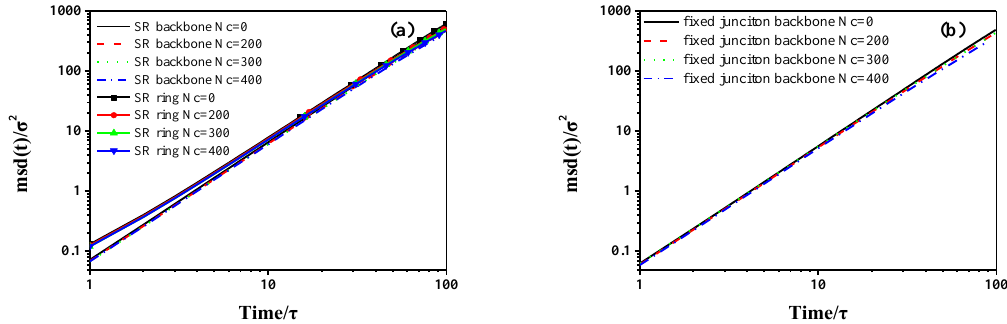
Figure 9. During the stretch process, the mean-square displacement (MSD) of ( a ) backbone and ring in SR systems; ( b ) backbone in the fixed junction systems with different number of cross-linked bonds, Nc . The curves are derived from statistical averages and each curve consists of 100 data points. The Figure 9 is the log-log version of the Figure S4.